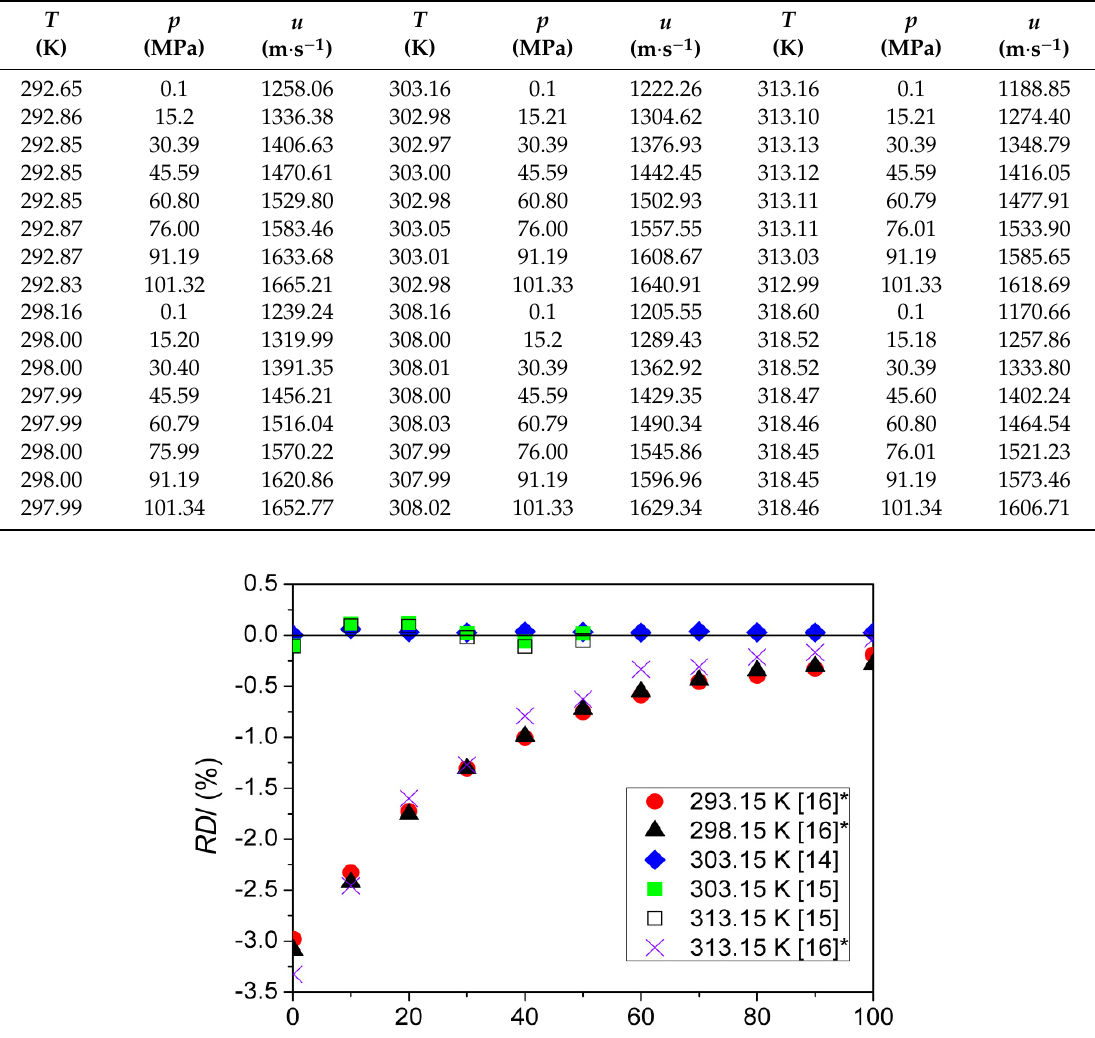
Table 2. The experimental speed of sound, u , in 1-butanol measured at pressures up to 101.34 MPa within the temperature range from (293 to 318) K.